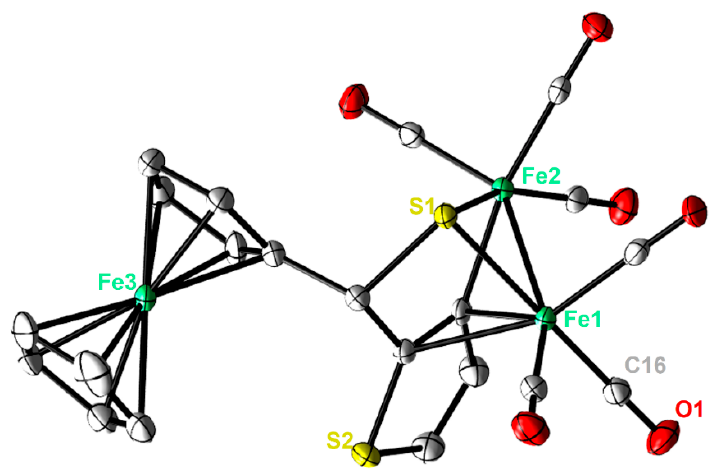
Figure 2. Molecular structures (50% probability) of 2 . All hydrogen atoms are excluded for clarity.